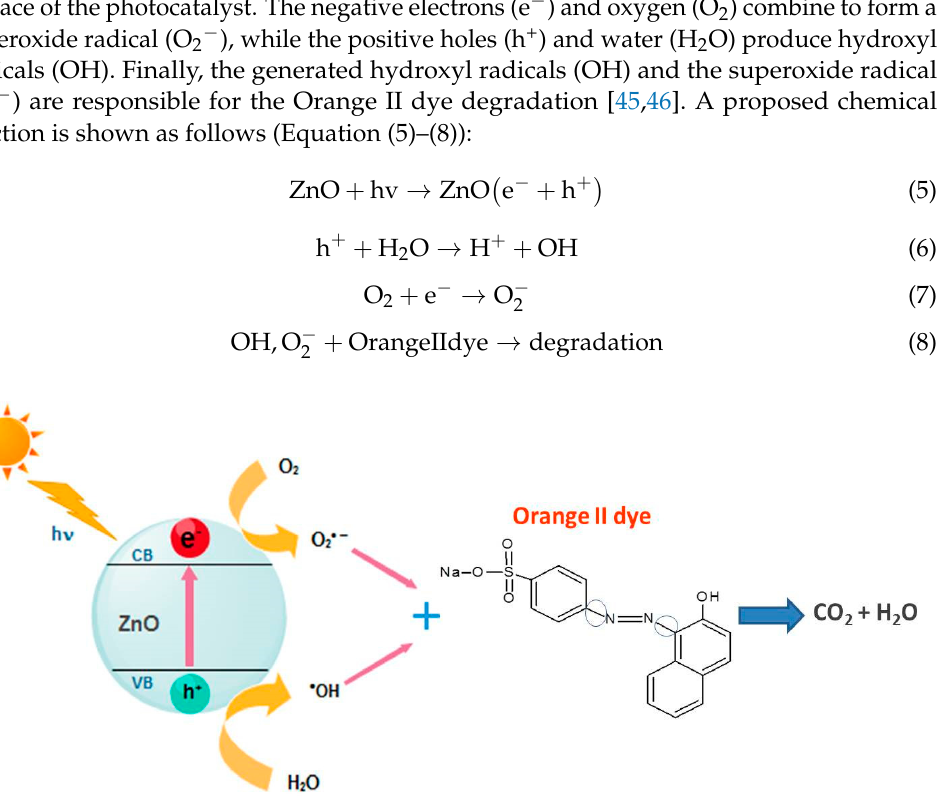
Figure 8. Mechanism of photocatalytic degradation of orange II dye by ZnO nanorods.